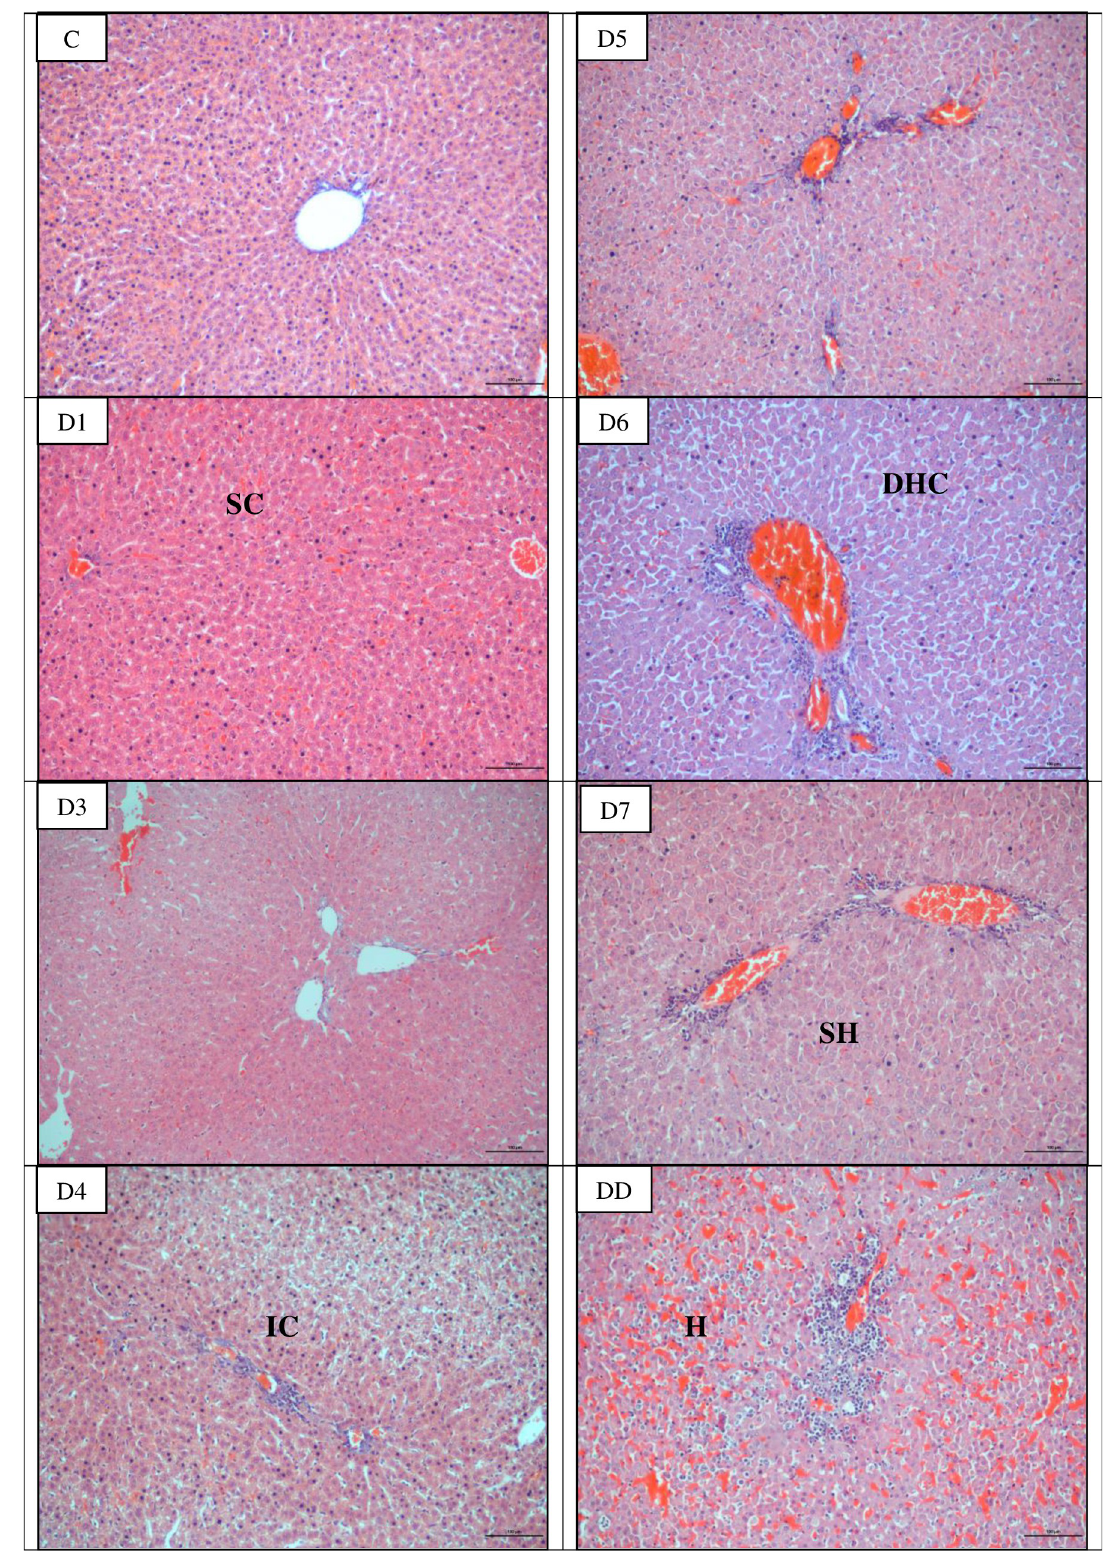
Fig 4. Histopathological lesions in the liver of infected hamsters. Congestion occurred as early as day 1 p.i. while infiltration of inflammatory cells, disorganized hepatocyte cords and swelling of hepatocytes occurred on day 4 p.i. onwards. SC: Sinusoid congestion, IC: Infiltration of inflammatory cells, DHC: Disorganized hepatocyte cords, SH: Swollen hepatocytes and H: Haemorrhage. C: Control, D1-D7: Day 1- day 7 and DD: Dead. Magnification: x100, bar: 100 μ m. https://doi.org/10.1371/journal.pntd.0010409.g004 PLOS NeglectedTropical Diseases | https://doi.org/10.1371/journal.pntd.0010409 May 18,